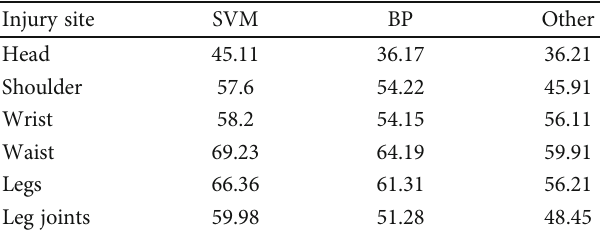
Table 3: Pattern recognition at di ff erent injury sites. Injury site